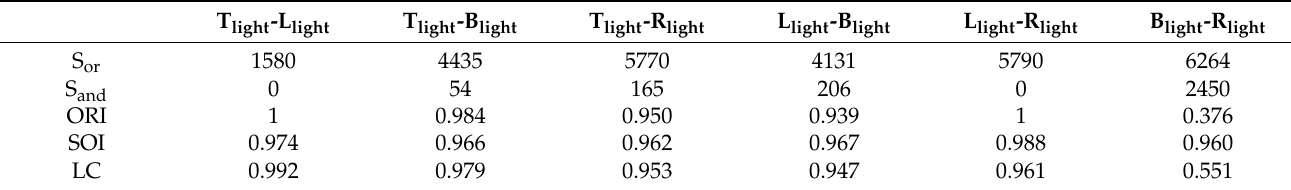
Table 4. Process data statistics for lighting solutions under Viewpoint ii.